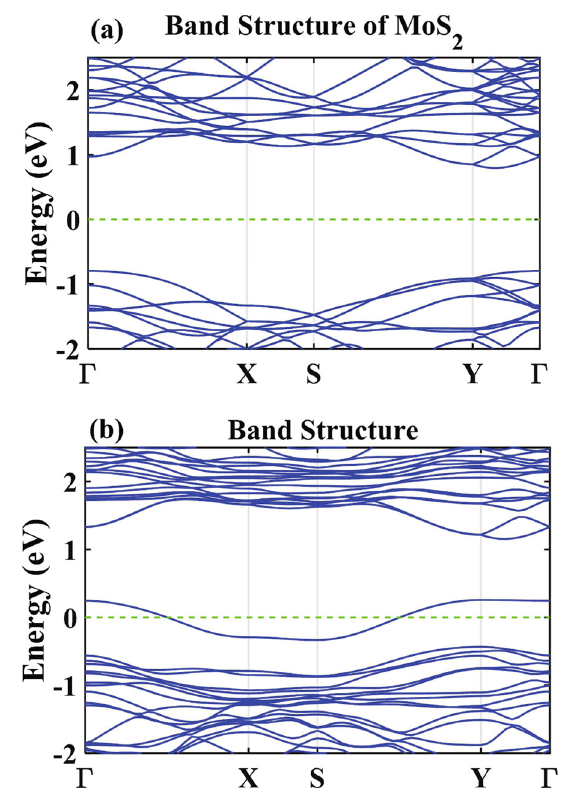
Fig. 2 Band structure of a monolayer MoS 2 and b nitrogen-doped monolayer